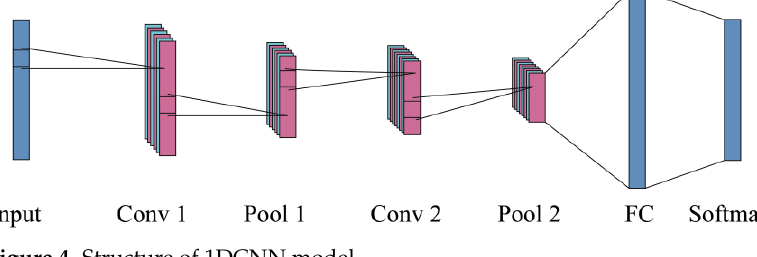
Figure 4. Structure of 1DCNN model.